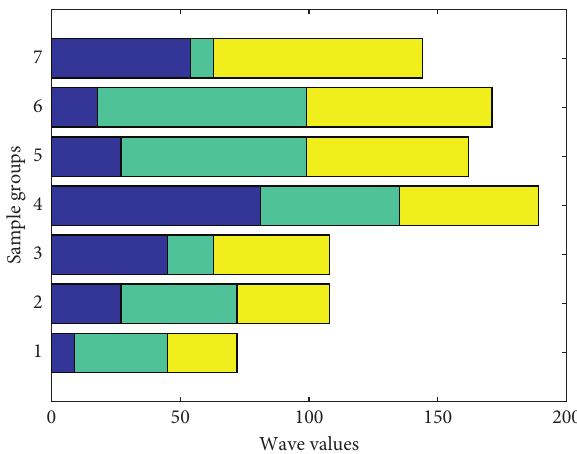
Figure 7: Brain wave data distribution of different music signal sample groups.